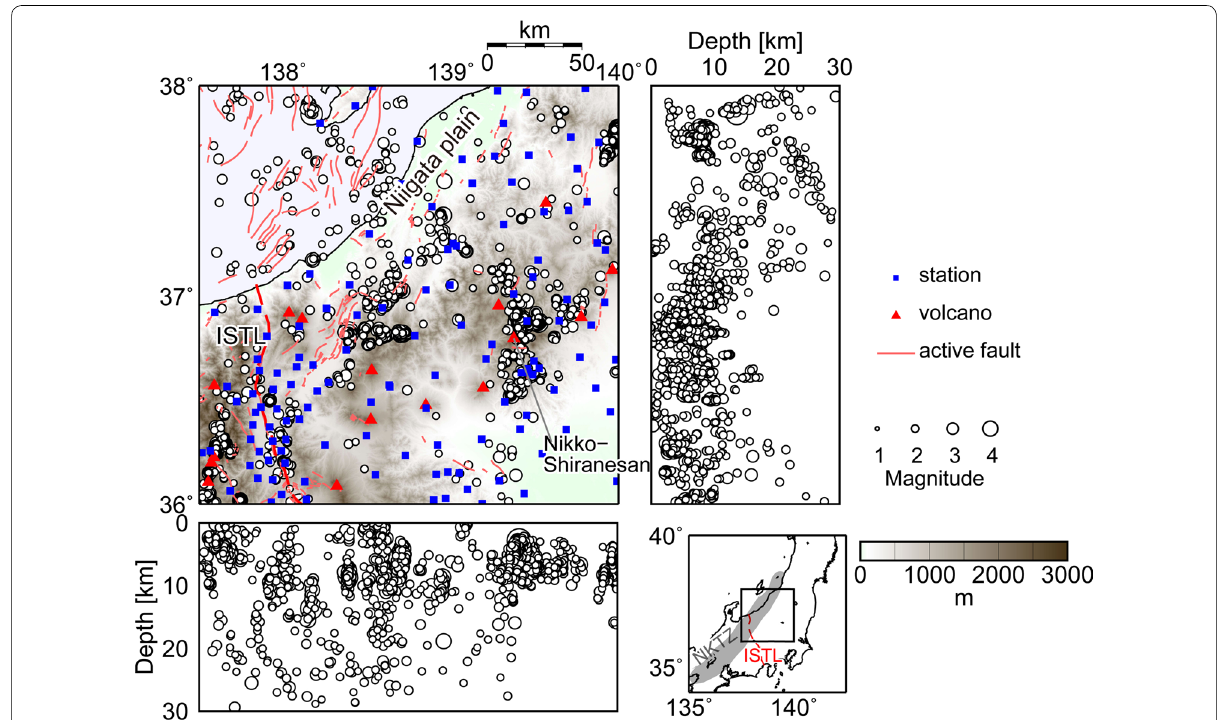
Fig. 1 Spatial distribution of epicenters ( circles ) and stations ( blue squares ) used in this study. Red lines show Quaternary active faults (Active Fault Research Group 1991), and red triangles show Quaternary active volcanoes. In a lower-right panel, red lines show the Itoigawa–Shizuoka Tectonic Line (ISTL) and a gray zone shows the Niigata–Kobe Tectonic Zone